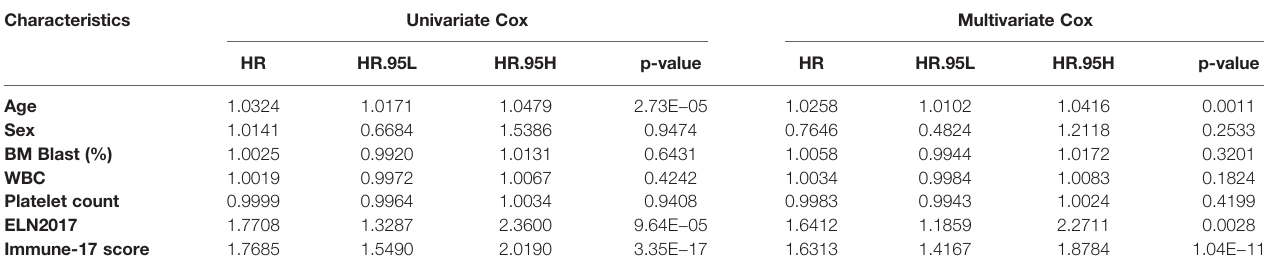
TABLE 3 | Univariate and multivariate Cox regression analysis of immune-17 model for overall survival of TCGA-LAML patients. Characteristics